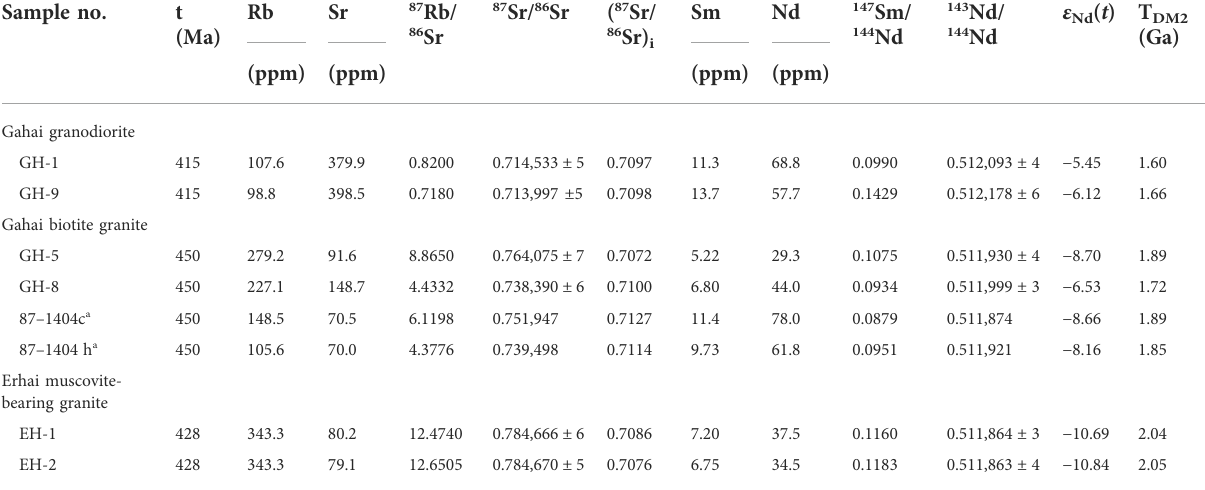
TABLE 3 Whole-rock Rb – Sr and Sm – Nd isotopic data for the Gahai and Erhai granitoids. Sample